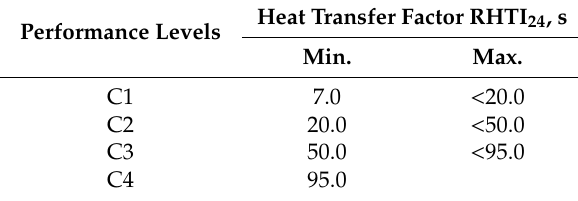
Table 4. Performance levels: radiant heat test